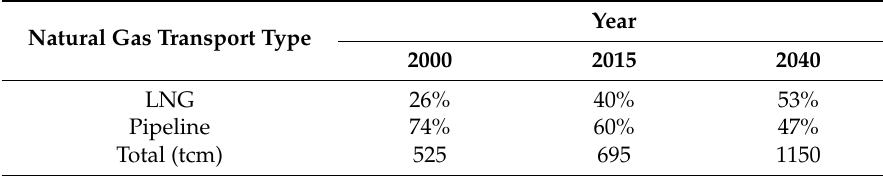
Table 8. Liquid natural gas (LNG) and pipeline shares on the global gas trade market, adapted from Reference